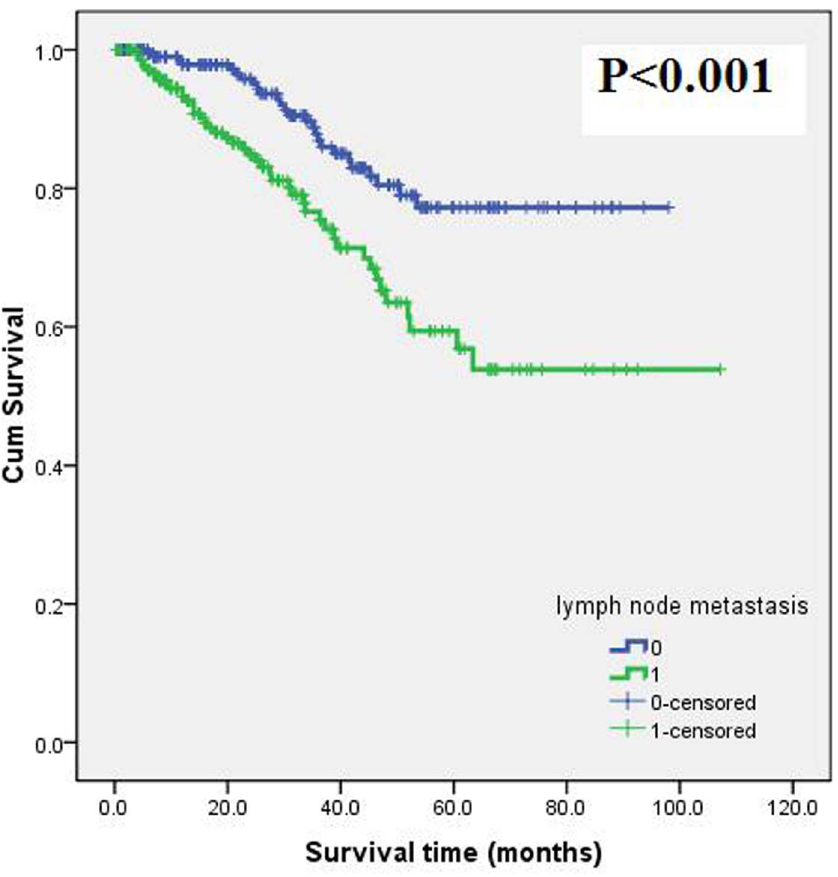
Figure 3. Survival analysis: Kaplan-Meier curve (log rank test) showed lymph node metastasis was associated with the prognosis (survival